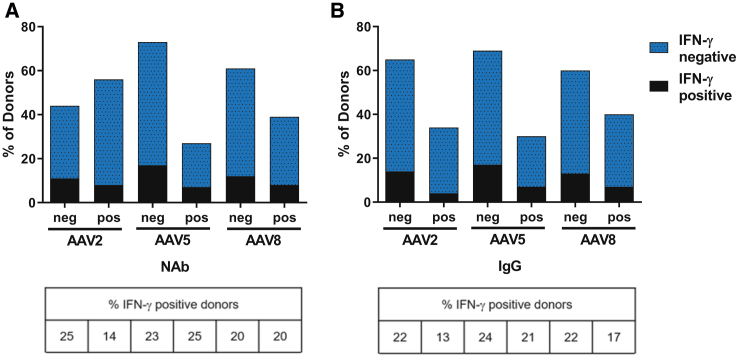
Correlation between T Cell and Antibody Responses against Different AAV SerotypesAAV-specific T cells were analyzed using an IFN-γ ELISpot assay in PBMCs from 90 healthy donors (the same donors as in Figure 3). The prevalence of T cells directed against AAV8, AAV5, and AAV2 was compared between (A) NAb-positive and NAb-negative or (B) IgG-positive and IgG-negative donors, indicating no correlation between T cell and antibody responses against AAV. The tables depict the proportion of IFN-γ-positive donors from each column of the figure.